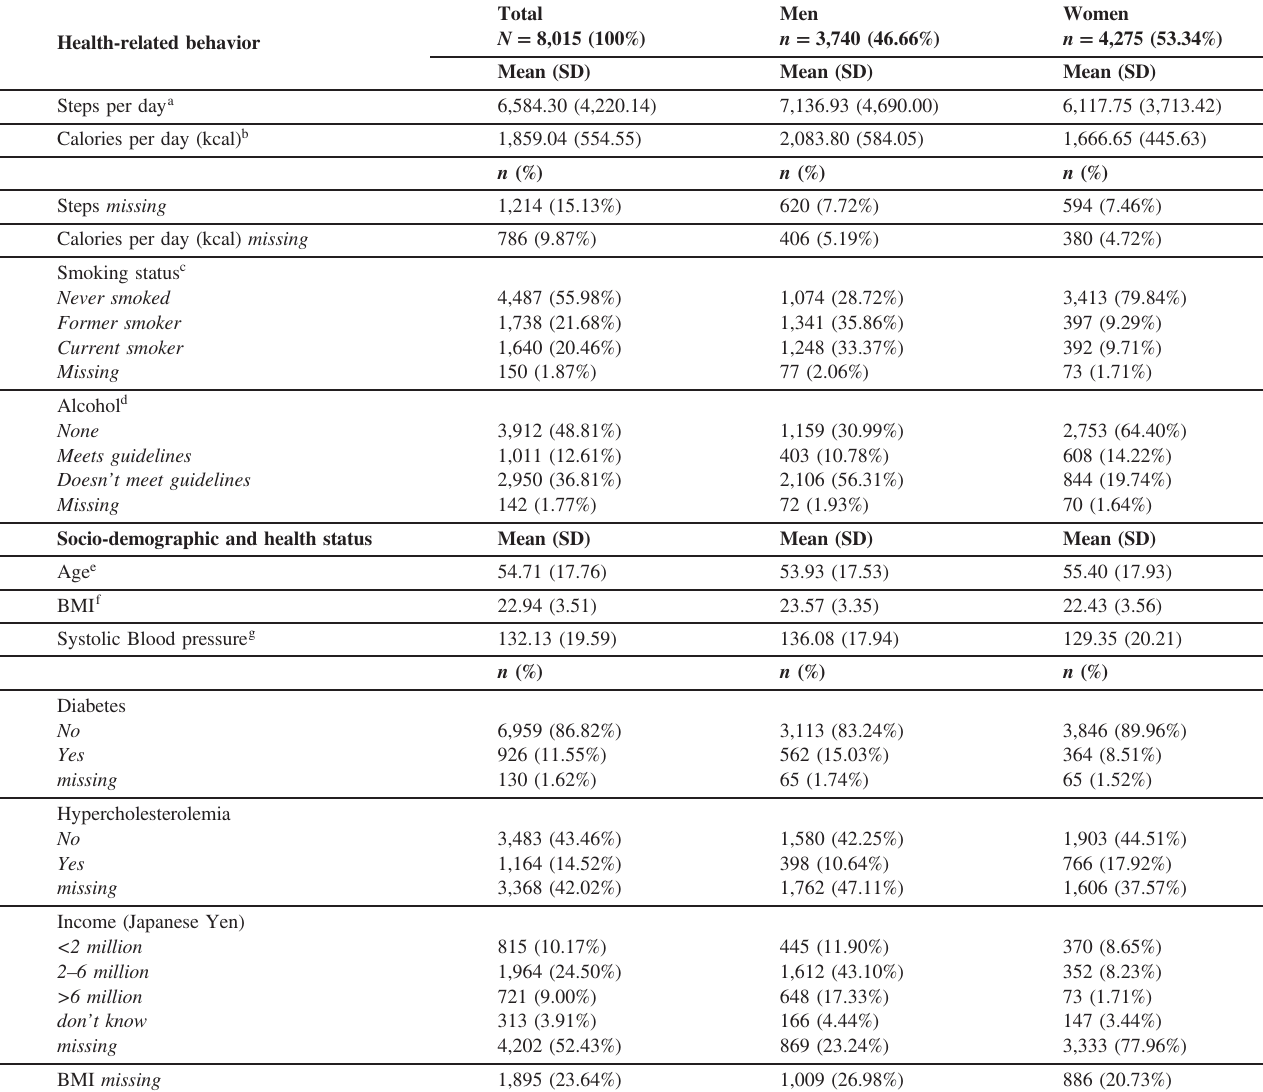
Table 1. Descriptive statistics for Health-related behavior, socio-demographic and health status measures Health-related